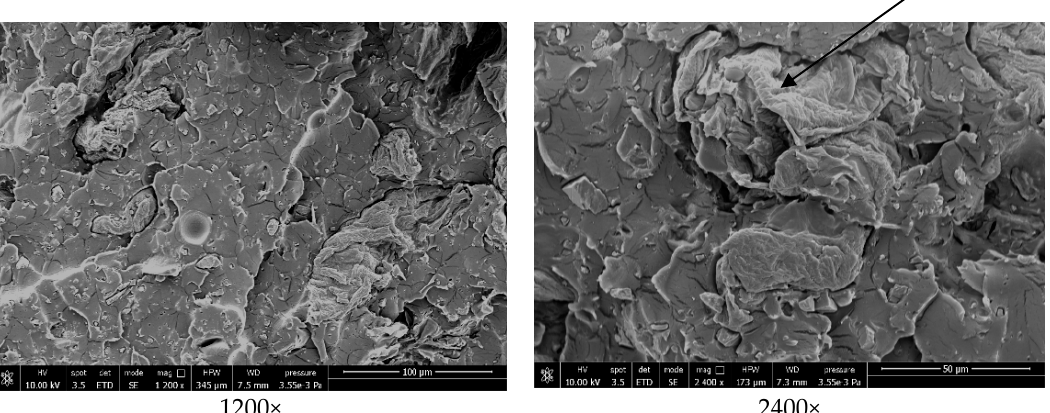
Figure 7. SEM images of the [PLA(85 wt.%) + ATBC(10 wt.%) + CaCO3(5 wt.%)](80 wt.%) + PPP(20 wt.%) biocomposite at the indicated magnification.